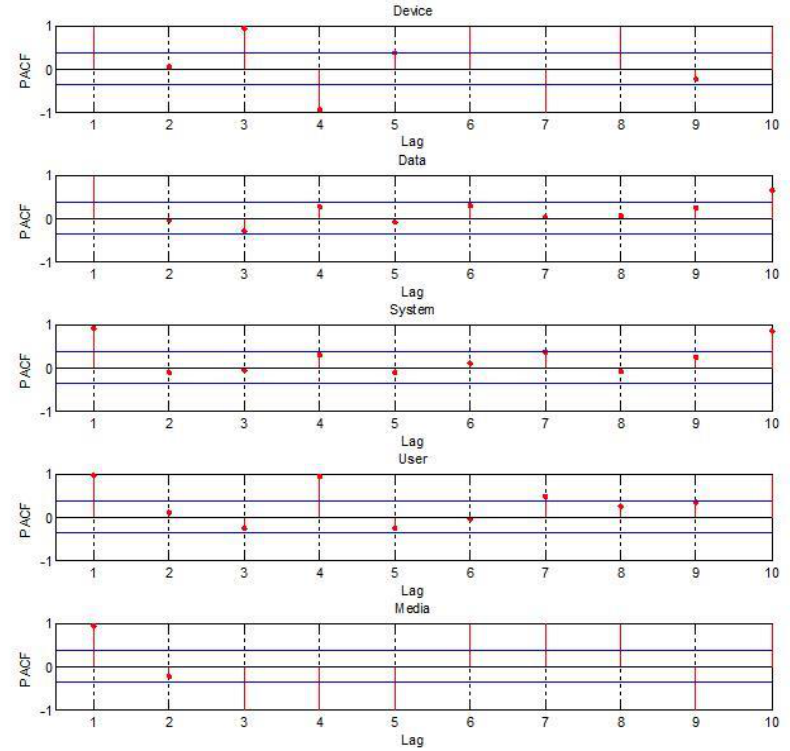
Figure 5. Partial autocorrelation function (PACF) plots of the top five keywords.